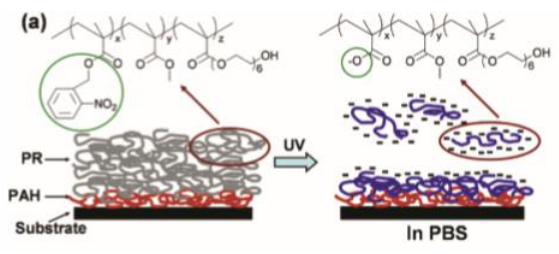
Figure 3. Chemical structure of Photoresist and its mechanism for in situ polyelectrolyte bilayer formation (Reprinted with the permission from reference [79] Copyright 2004 American Chemical Society).